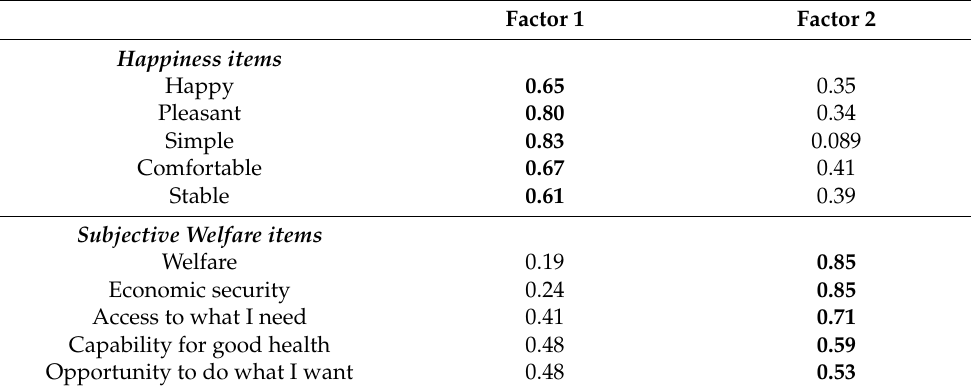
Table 3. Factor loadings for happiness and subjective